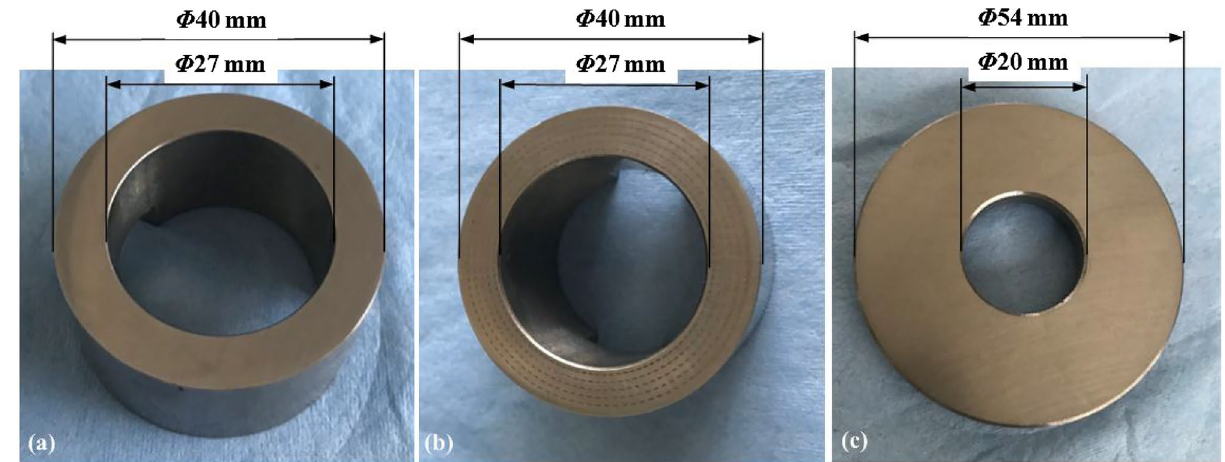
Figure 1. Photographs and dimensions of test samples: ( a ) rotational sample without textures; ( b ) rotational sample with textures; ( c ) stationary